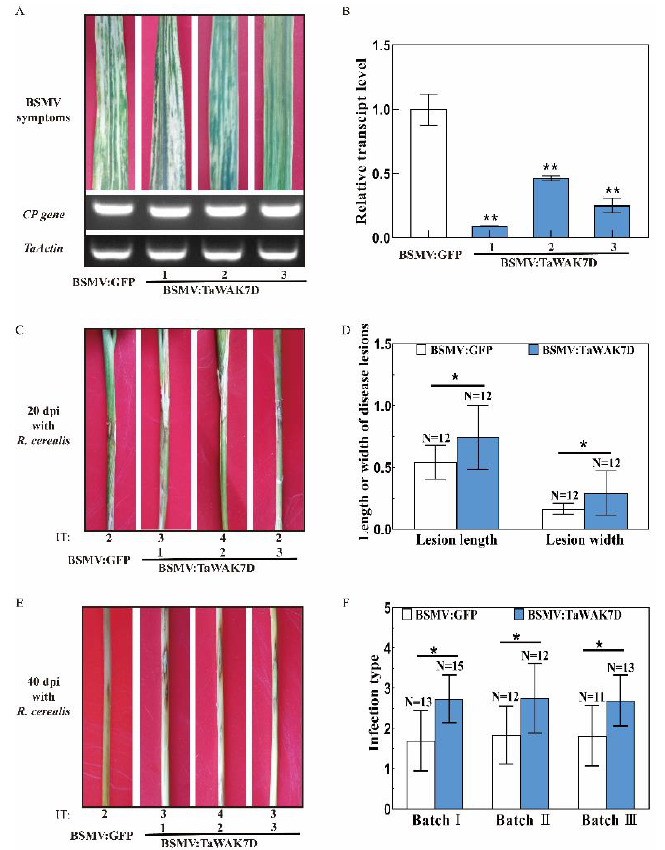
Figure 5. Silencing of TaWAK7D impairs resistance of the wheat cv. CI12633 to R. cerealis . ( A ) Typical symptom of BSMV in the fourth leaves of wheat plants infected by BSMV:GFP or BSMV:TaWAK7D at 15 dpi with BSMV and RT-PCR analysis of the transcription of the BSMV CP gene. ( B ) qRT-PCR analysis of the relative transcript level of TaWAK7D in BSMV:GFP or